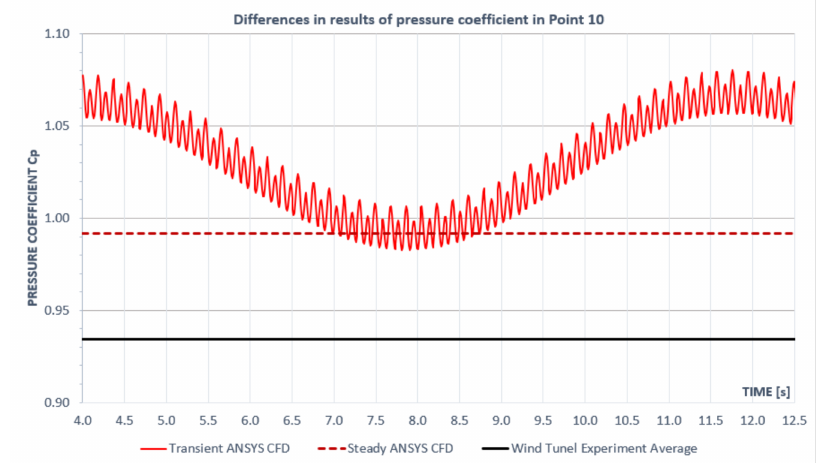
Figure 15. Comparison of wind pressure coefficients (Cp) varying in time and wind speed for sampling point 10 and wind direction 1.